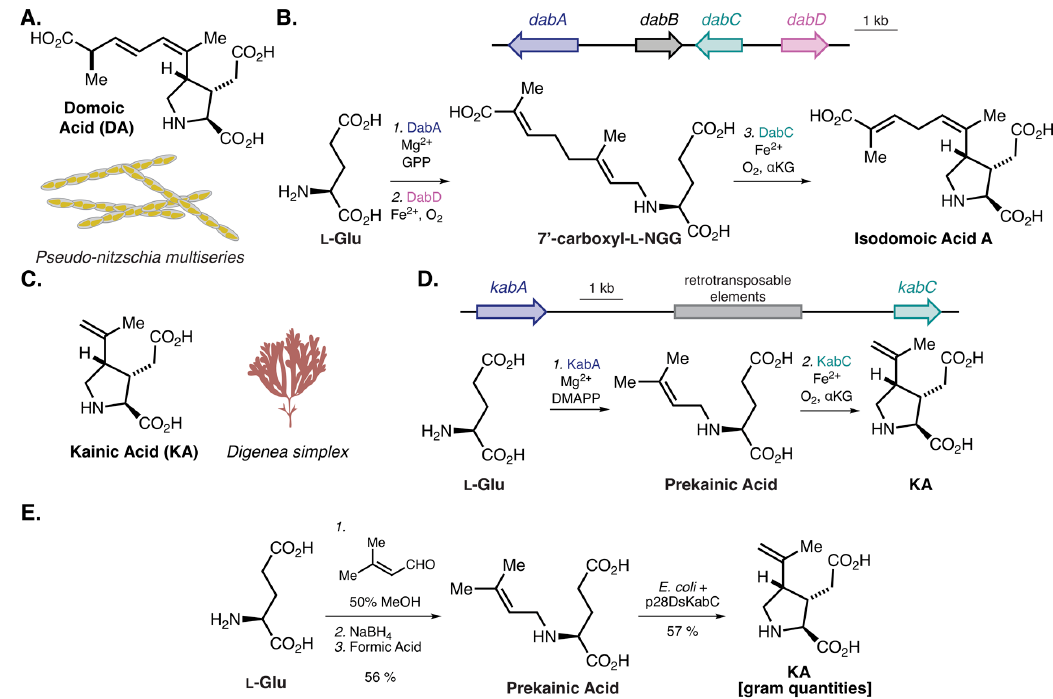
Figure 4. Natural products and their biogenesis from marine eukaryotes. ( A ) Structure of DA from the diatom Pseudo ‐ nitzchia multiseries . ( B ) The domoic acid (DA) BGC from Pseudo ‐ nitzchia multiseries and the biosynthesis to isodomoic acid A [79]. L ‐ NGG; N ‐ geranyl ‐ L ‐ glutamic acid. ( C ) Structure of kainic acid (KA) from the seaweed Digenea simplex . ( D ) The KA BGC from Digenea simplex and